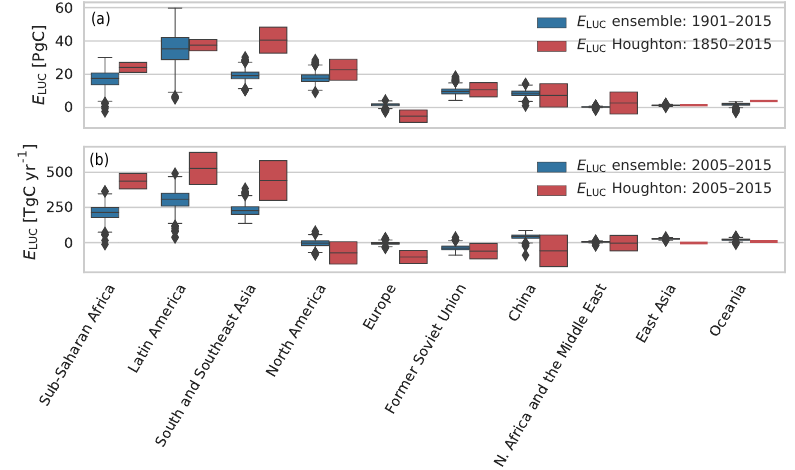
Figure 5. E LUC as simulated by the ensemble M gross , net compared to the Houghton and Nassikas (2017) estimates. The E LUC of the ensemble was calculated for individual countries and then aggregated to 10 regions defined in Houghton and Nassikas (2017). Panel (a) shows the estimates for the emissions over the industrial period; for LPX gridded output is only available after 1901. Panel (b) shows the annual mean emissions from 2005 to 2015. The Houghton and Nassikas (2017) estimates include the reported uncertainties based on the standard deviation of five quasi-independent studies; for East Asia and Oceania no uncertainty is reported.